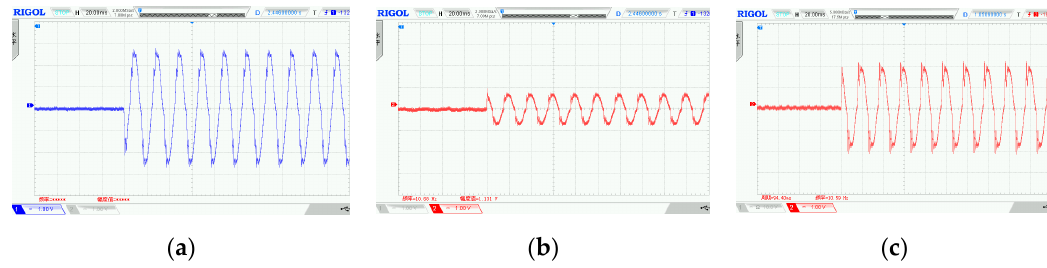
Figure 14. Experimental results of zero-sequence currents when a single-phase earth fault occurs on the middle of the first feeder: ( a ) first feeder; ( b ) second feeder; and ( c ) third feeder.